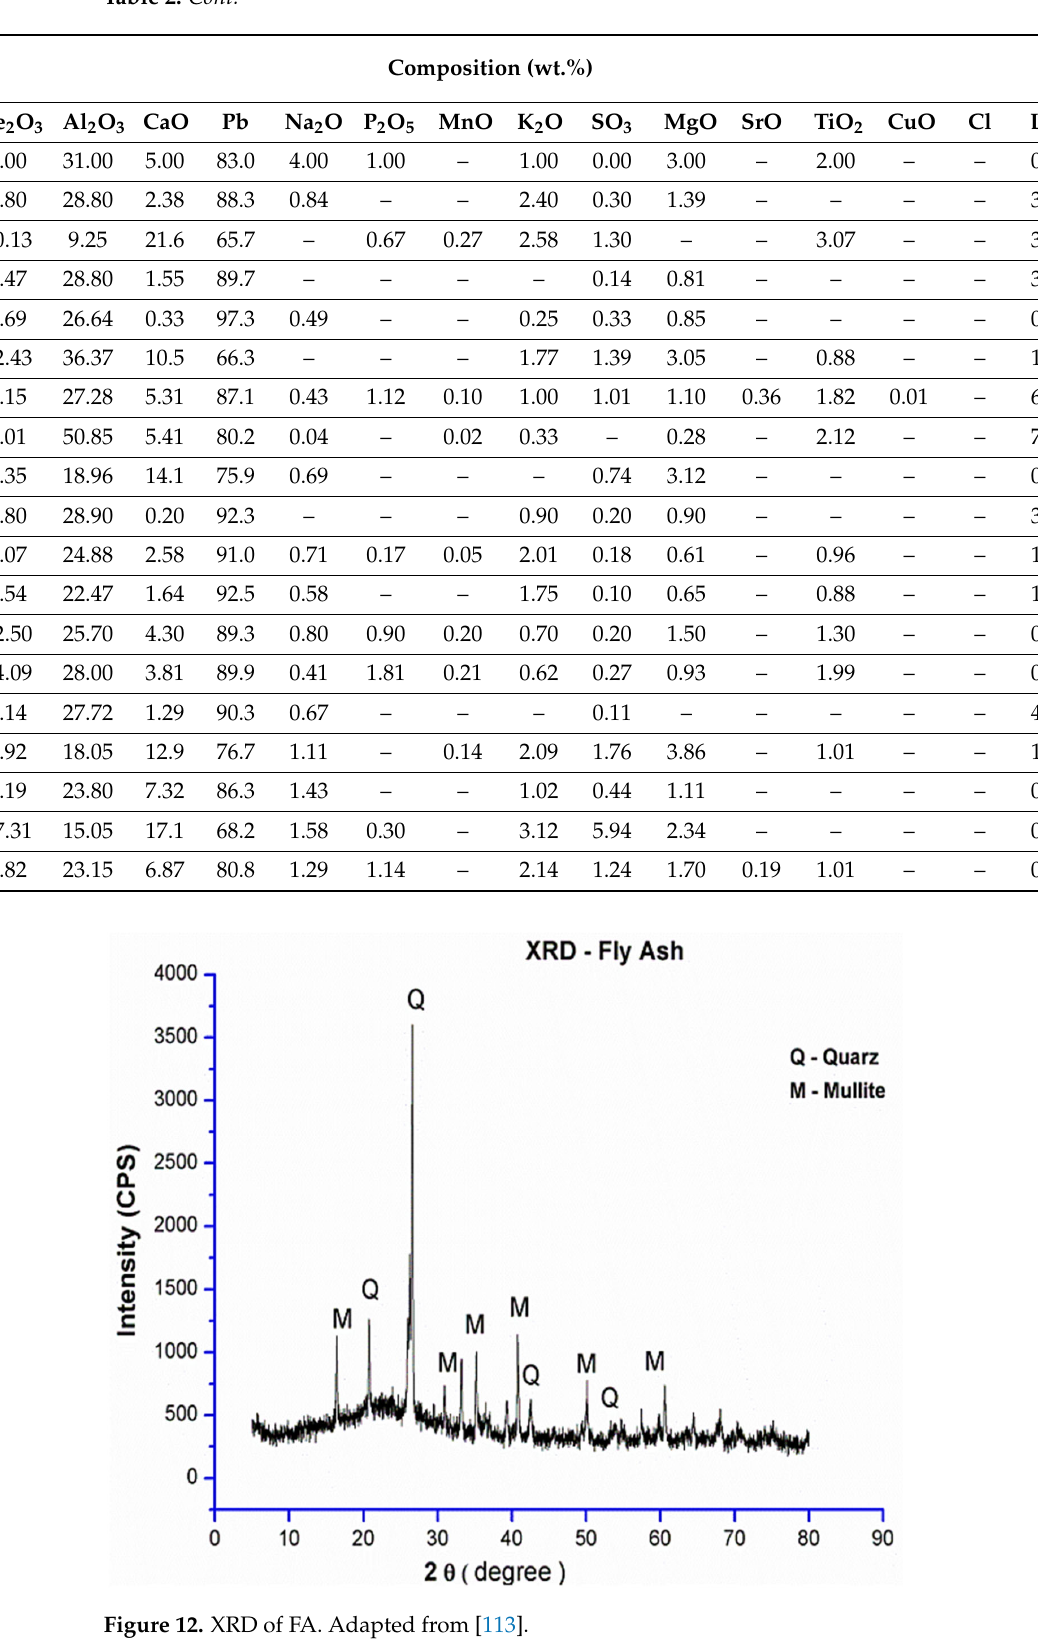
Table 2. Oxide composition for PC and FA binder materials. Material and Ref.